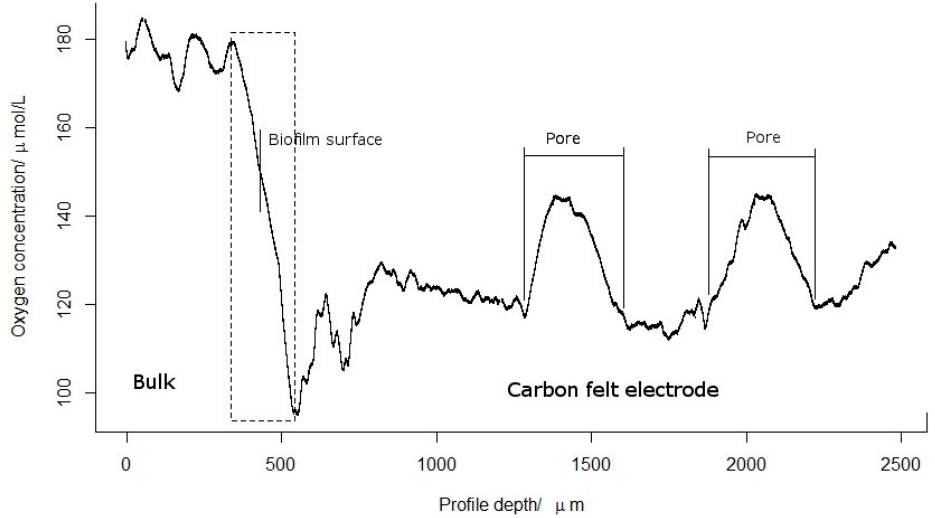
Figure 2. DO concentration profile in a carbon felt electrode colonised by an exoelectrogenic biofilm.